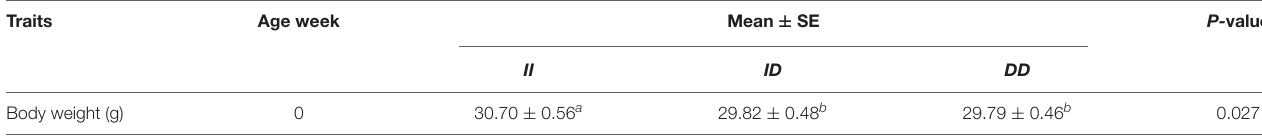
TABLE 4 | Effect of RIN2 gene polymorphisms on the growth traits of the F 2 population. Traits